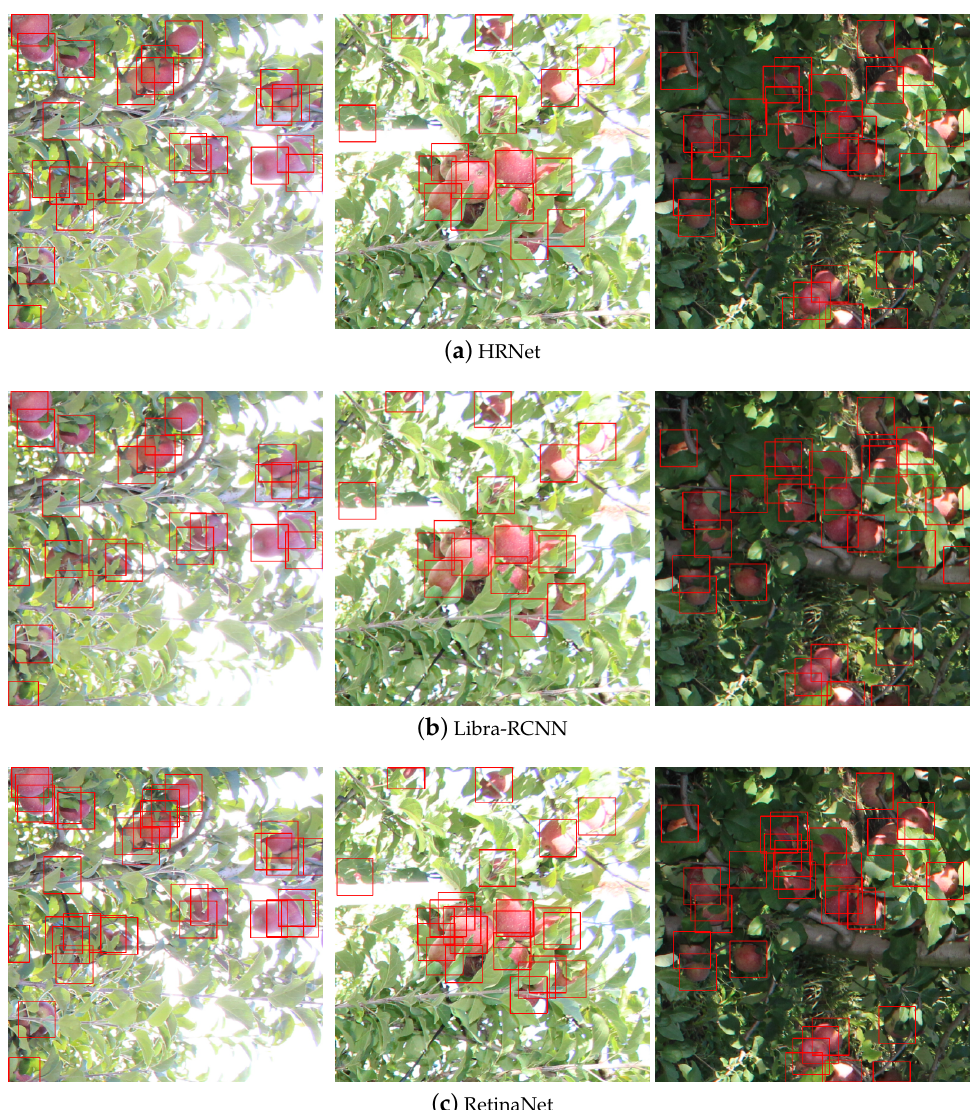
Figure 8. Examples of apple detection using ( a ) High-Resolution Network (HRNet), ( b ) Libra-Regions with Convolutional Neural Network (Libra-RCNN), and ( c )